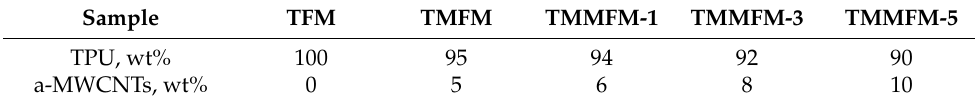
Table 1. Constituents of composite membranes.